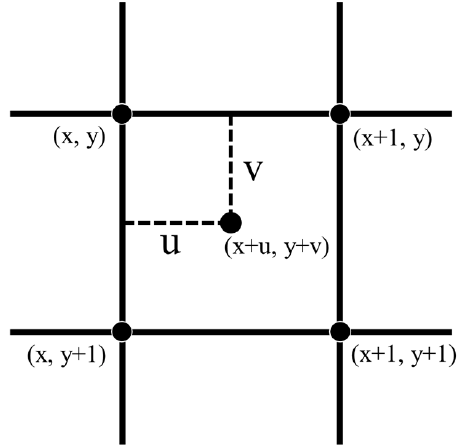
Figure 2. Schematic diagram of the bilinear interpolation method. The value taken at the place of ( x + u , y + v ) is calculated using Formula (5):